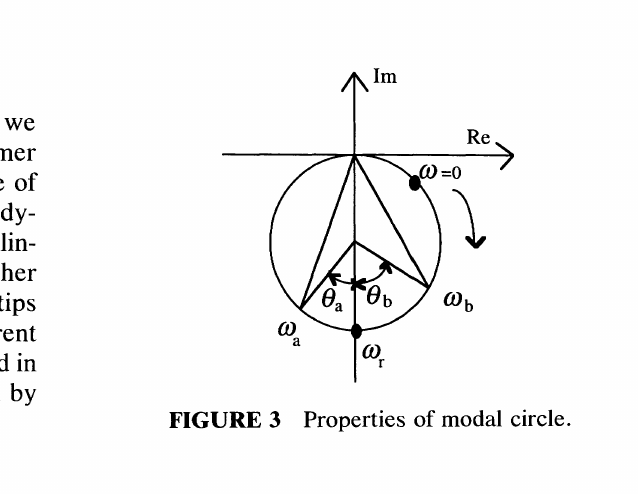
FIGURE 3 Properties of modal